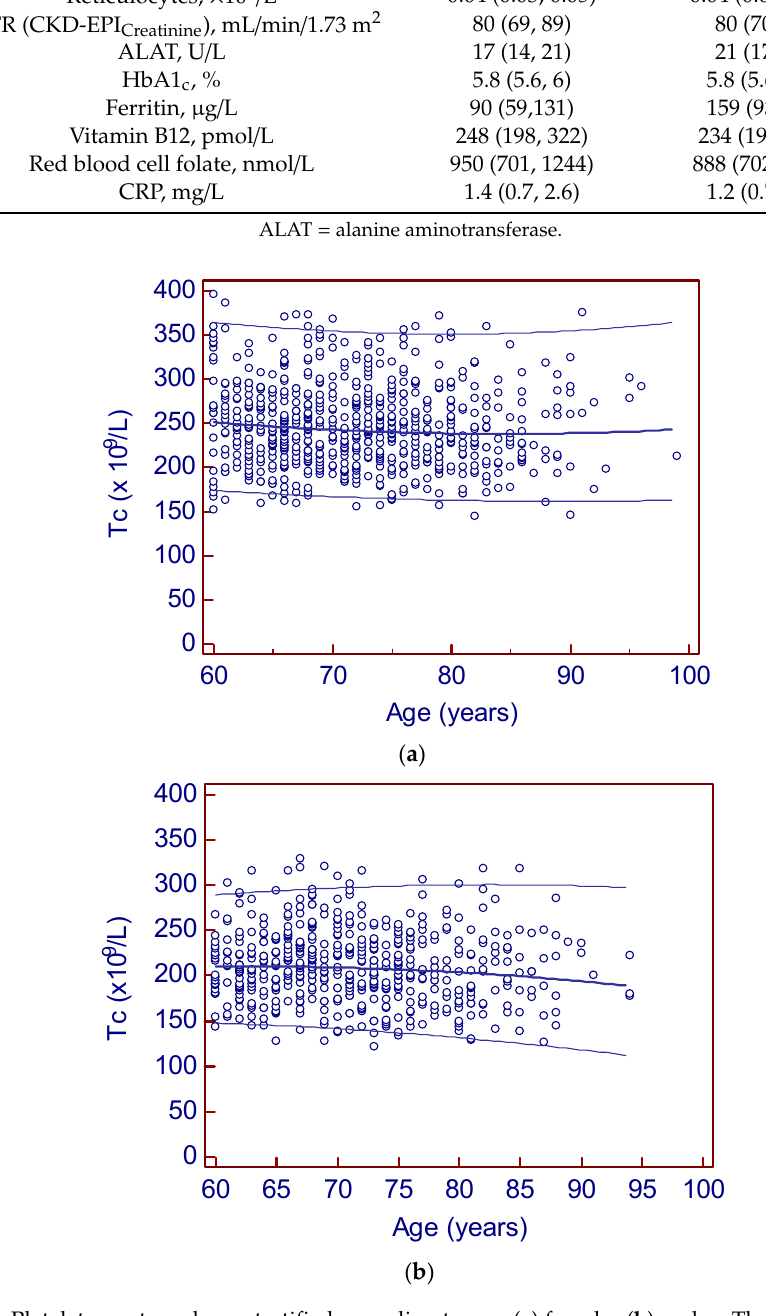
Figure 2. Platelet counts and age stratified according to sex: ( a ) females ( b ) males. The 2.5th to 97.5th percentiles, according to Altman [37], are shown as thinner lines; thicker lines depict medians. Table 1. Baseline characteristics of participants included in direct reference interval determination for platelet count. Summary statistics are given as medians with interquartile range (IQR).